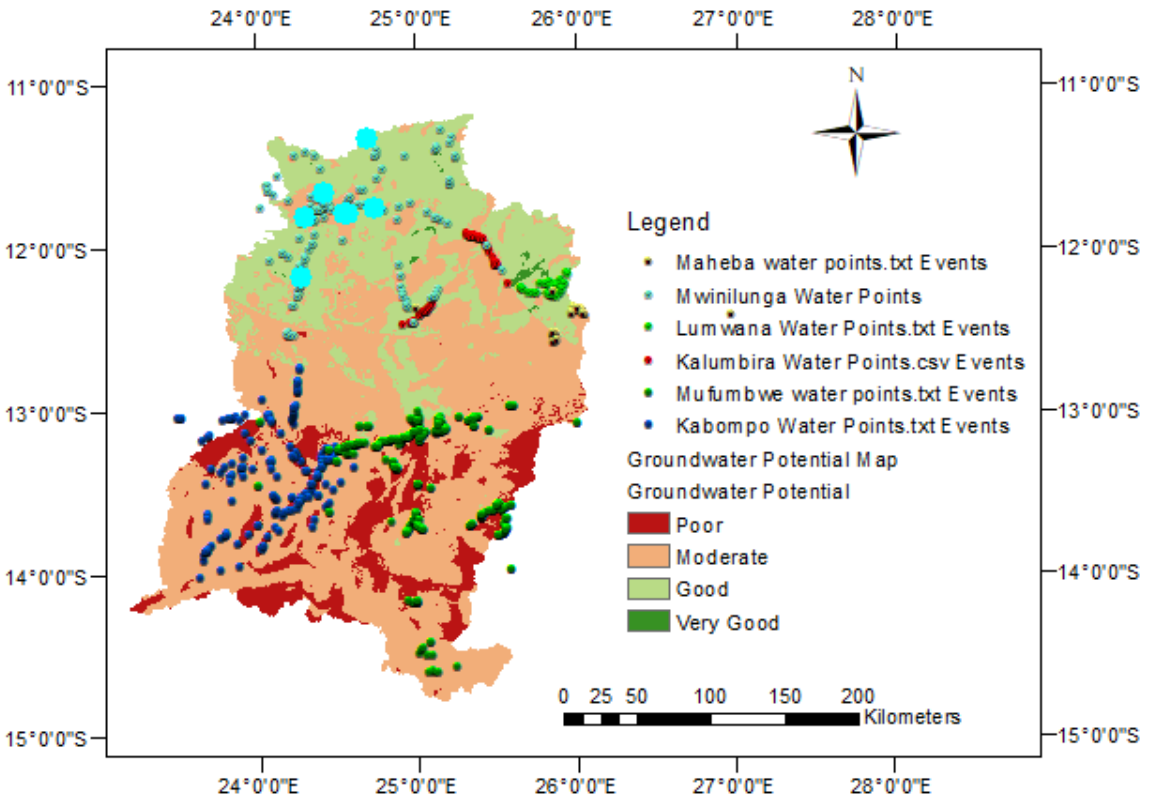
Figure 11. Groundwater points overlaid on groundwater potential map.